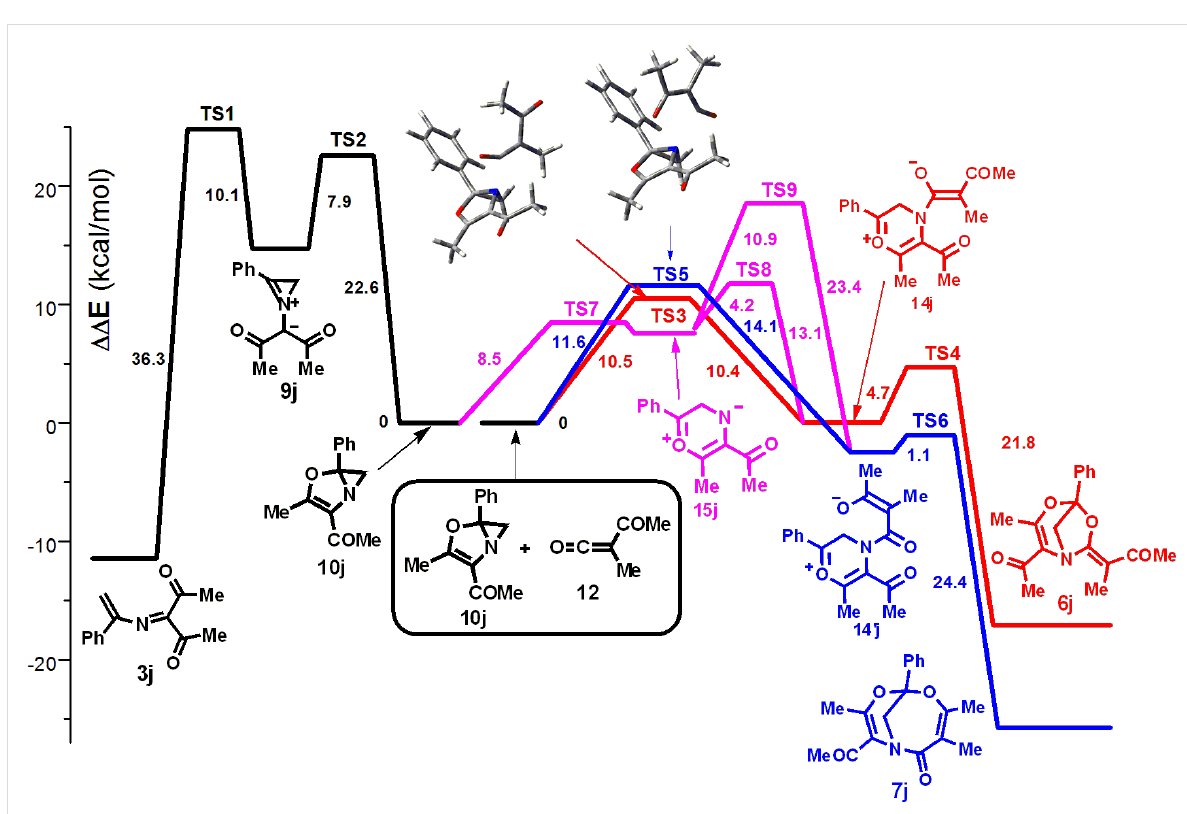
Figure 3: Energy profiles [DFT B3LYP/6-31+G(d,p), 357 K, 1,2-dichloroethane (PCM)] for the transformation of ylide 9j into azadiene 3j and dihy- droazireno[2,1- b ]oxazole 10j and for the transformation of 10j to adducts 6j , 7j